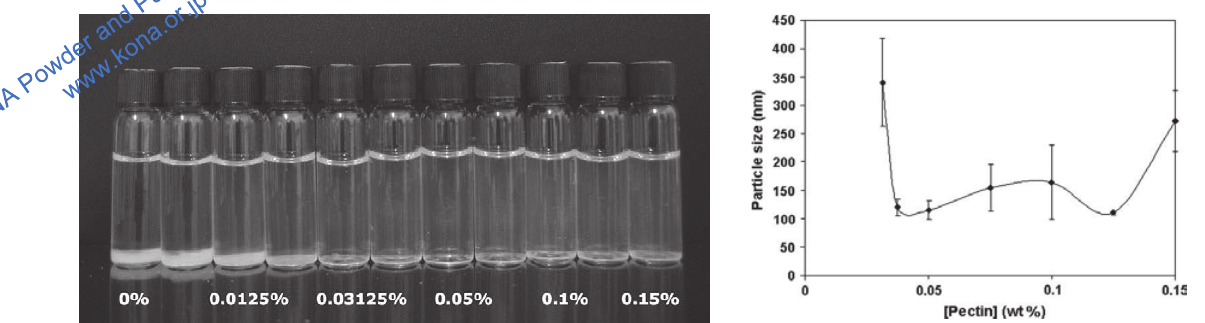
Fig. 9 Colloidally stable nanocomplexes of DHA-loaded β -lactoglobulin and increasing concentration of low me- thoxyl pectin. A precipitate is visible in the first four vials while the dispersions in the other vials are trans- parent. The visual observation correlates well with the mean particle size of the complexes as a function of the pectin concentration. Transparent, stable solutions had average particle sizes of ~100 nm 103)